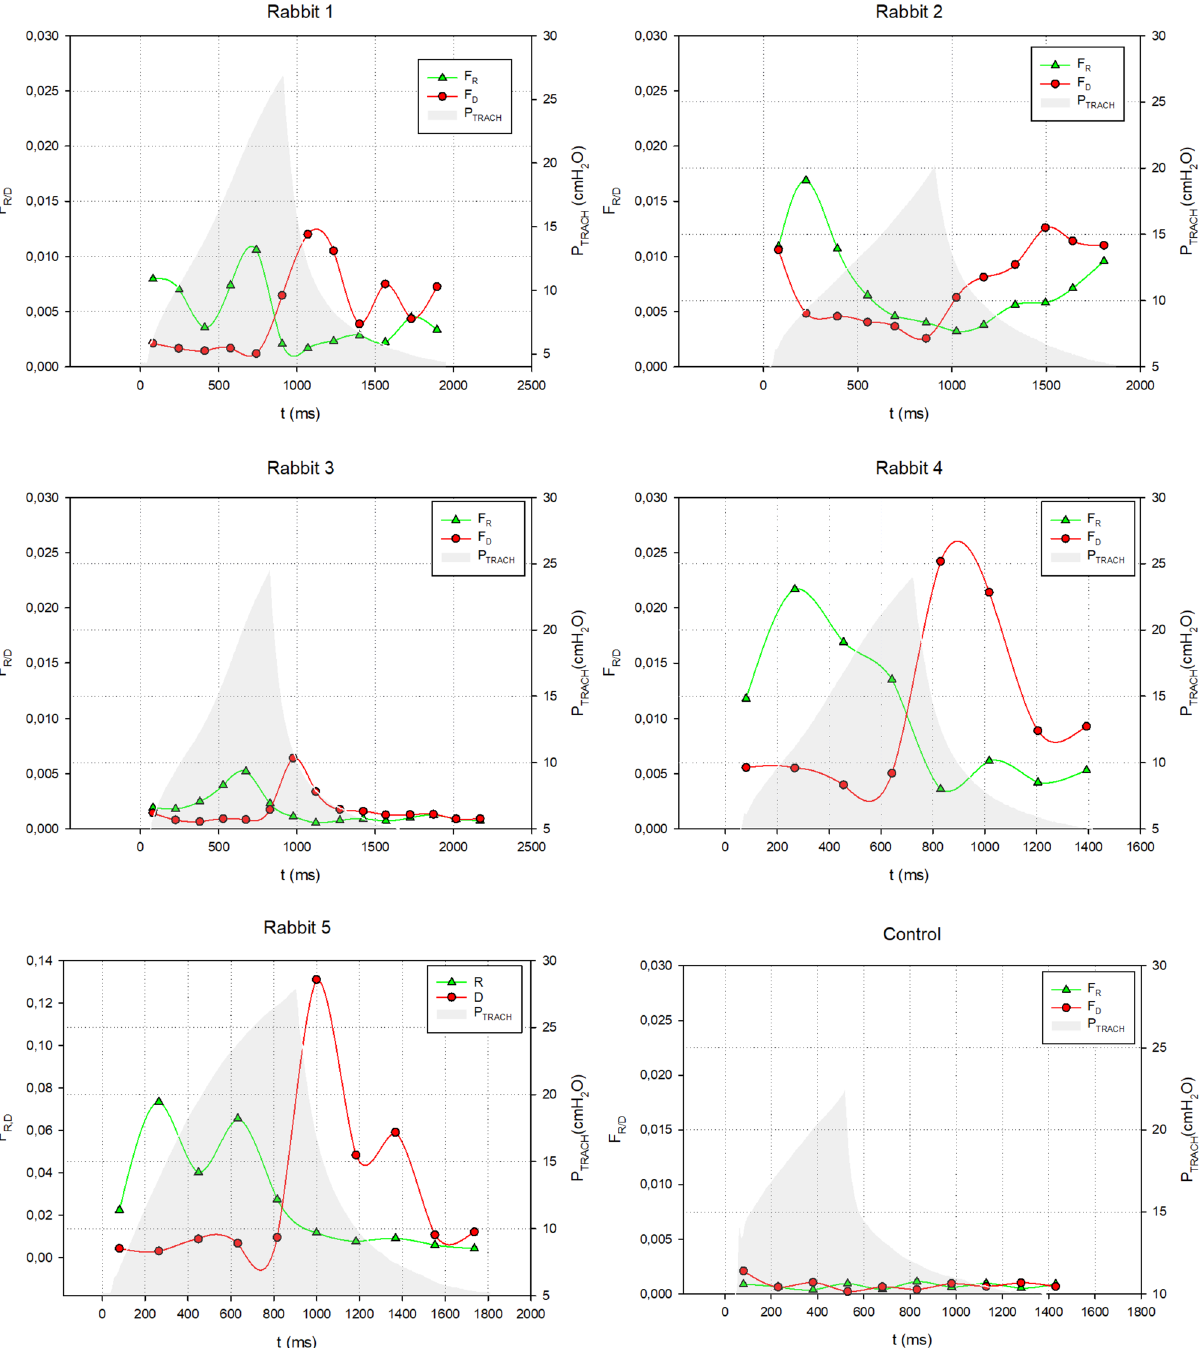
Figure 5. Graphs representing the recruitment (F R ) and derecruitment (F D ) fraction as a function of time for all the rabbits. The pressure–time curve is shown as a reference. Rabbit-5, having a different injury model, is represented as last graph, with a different scale for the recruitment and derecruitment